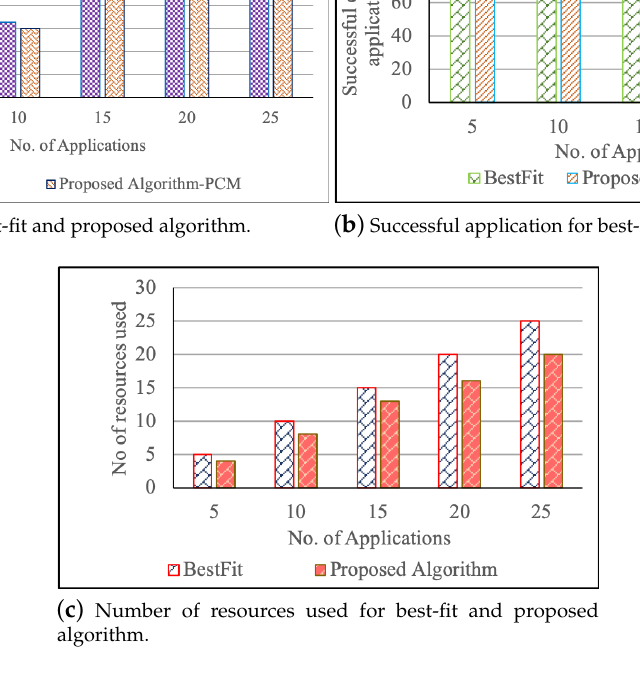
Figure 4. Comparison of cost, resources used and successful application between the Proposed and BestFit algorithm when the fog devices are equal to number of